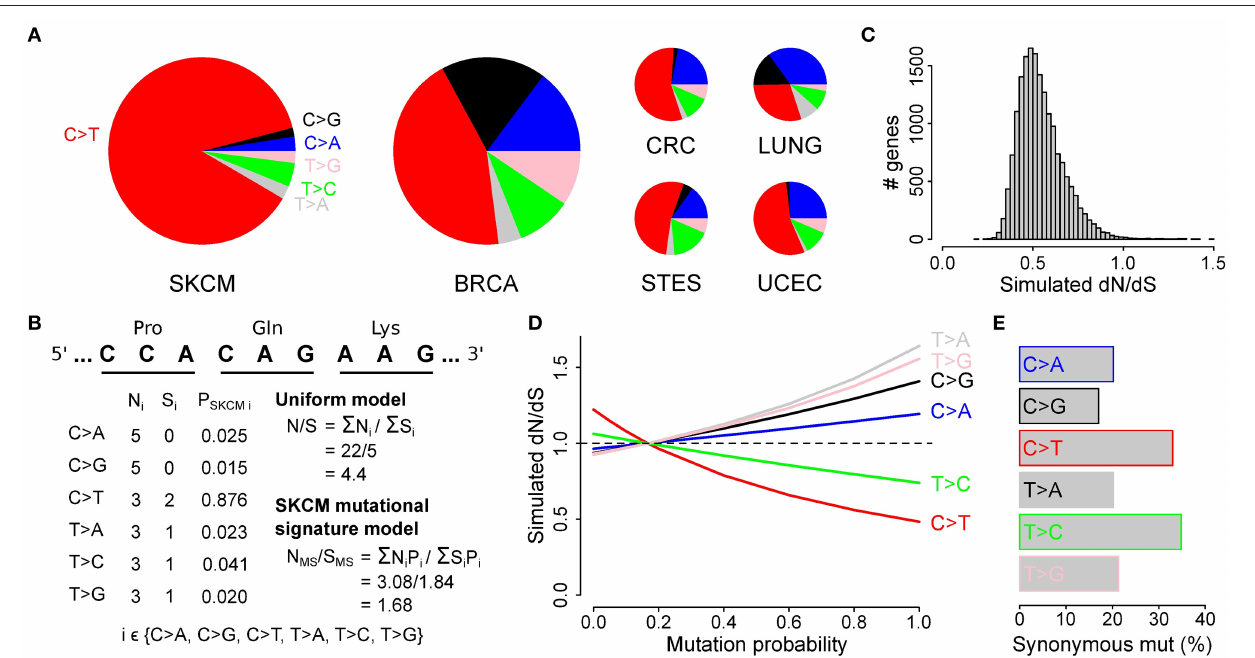
FIGURE 2 | Abundant C to T mutations in malignant melanoma bias dN/dS ratios toward lower values. (A) Pie charts show the proportions of the 6 main substitution classes for malignant melanoma, breast cancer, and the other 4 cancers as indicated. (B) Calculation of the expected ratio of non-synonymous (N) to synonymous (S) mutations in 3 random exemplified codons based on the simple uniform model and after correcting for the mutation probabilities using the malignant melanoma 6-class mutational signature shown in (A) . (C) Simulation of the effect of the malignant melanoma mutation signature on the observed (uniform) dN/dS values. The simulated dN/dS values are calculated by normalizing N MS /S MS to N/S for each gene. (D) Median simulated dN/dS as a function of different proportions of substitution classes (i.e., mutation probabilities) as indicated on the x-axis. (E) Bar plots show the proportion of all synonymous codon mutations for each substitution